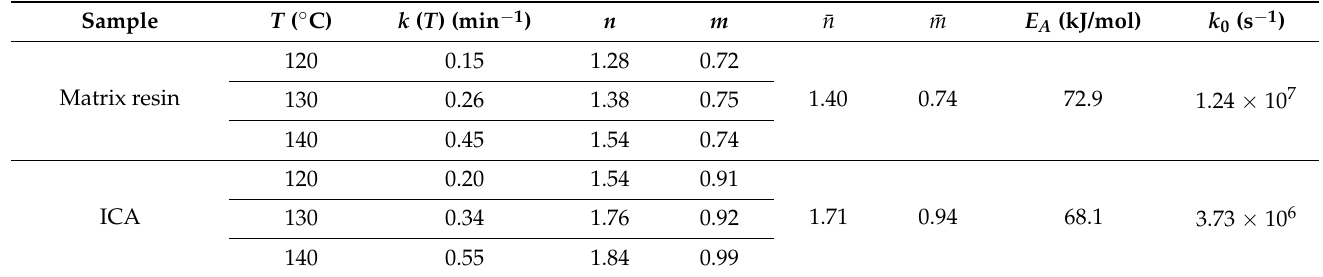
Table 2. Calculated curing kinetics parameters of the Ag-filled ICA and its matrix resin.